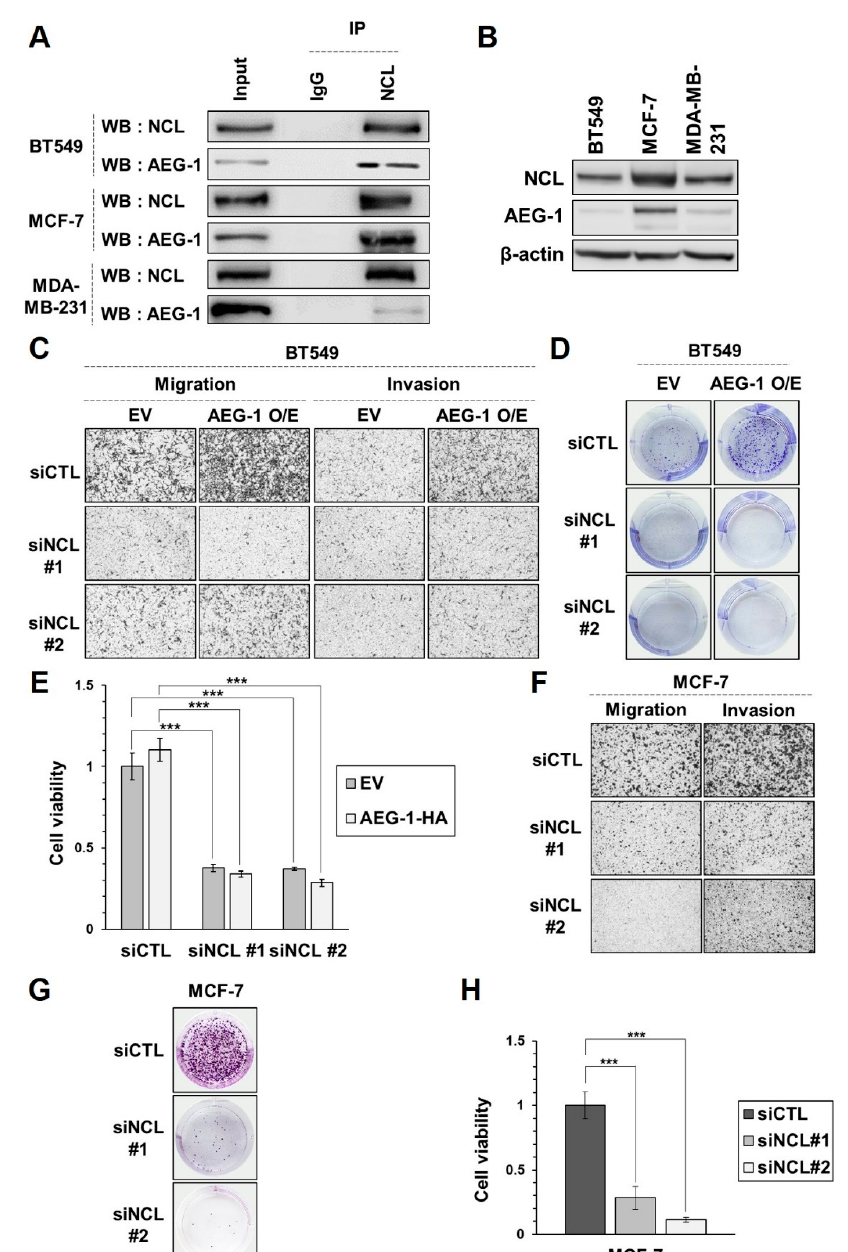
Figure 3. NCL knockdown reduces proliferation as well as the cell migration/invasion induced by the overexpression of AEG-1 in breast cancer cell lines. ( A ) Endogenous NCL was immunoprecipitated in a panel of breast cancer cell lines (BT549, MCF-7, MDA-MB-231), then co-immunoprecipitated AEG-1 was detected by western blot. ( B ) The expression levels of AEG-1 and NCL were analyzed in breast cancer cell lines. ( C – E ) BT549 cells were transfected with the indicated siRNAs before the AEG-1-HA or empty vector (EV) plasmids were transfected 2 days later. Migration/invasion and proliferation of transfected cells were analyzed by transwell migration/invasion assay ( C ), and clonogenic ( D ) and MTT ( E ) assay, respectively. ( F – H ) MCF-7 cells were transfected with the indicated siRNAs, then the migration/invasion and proliferation of the transfected cells were analyzed by transwell migra- tion/invasion assay ( F ), and clonogenic ( G ) and MTT ( H ) assay, respectively. Representative data from three independent experiments with similar results are shown. *, p < 0.05; **, p < 0.01; and ***, p < 0.001 with mean ± SE are shown. Validation of transfection and quantitative analyses are shown in Figure S3. O/E: over